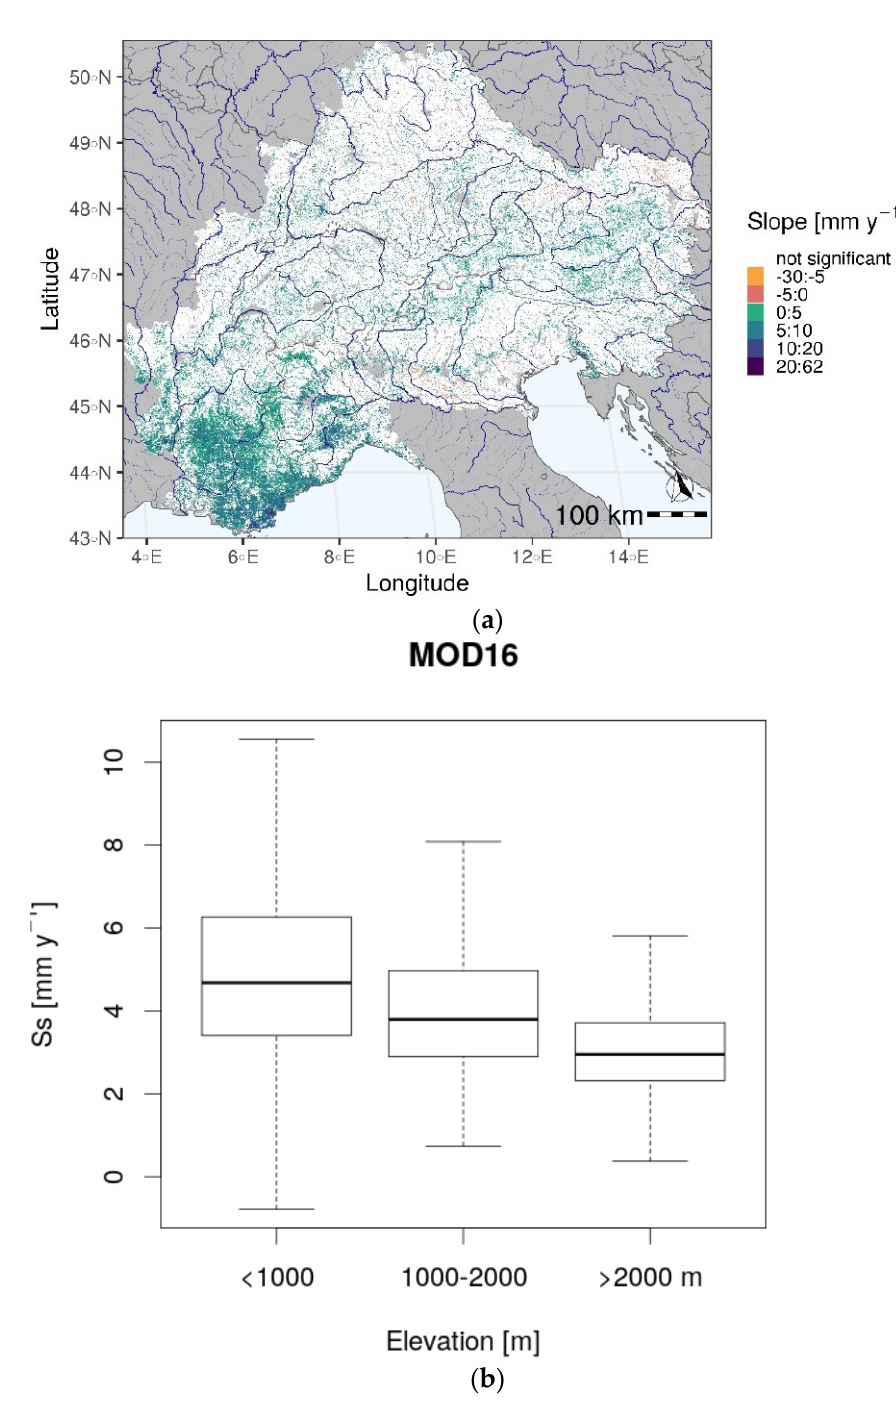
Figure 1. Sen’s slope of the trend at 5% significance level for yearly ET from the MOD16 product ( a ); boxplot of the distribution of the slope (Ss) with elevation ( b ). The period of investigation is 2003–2019.